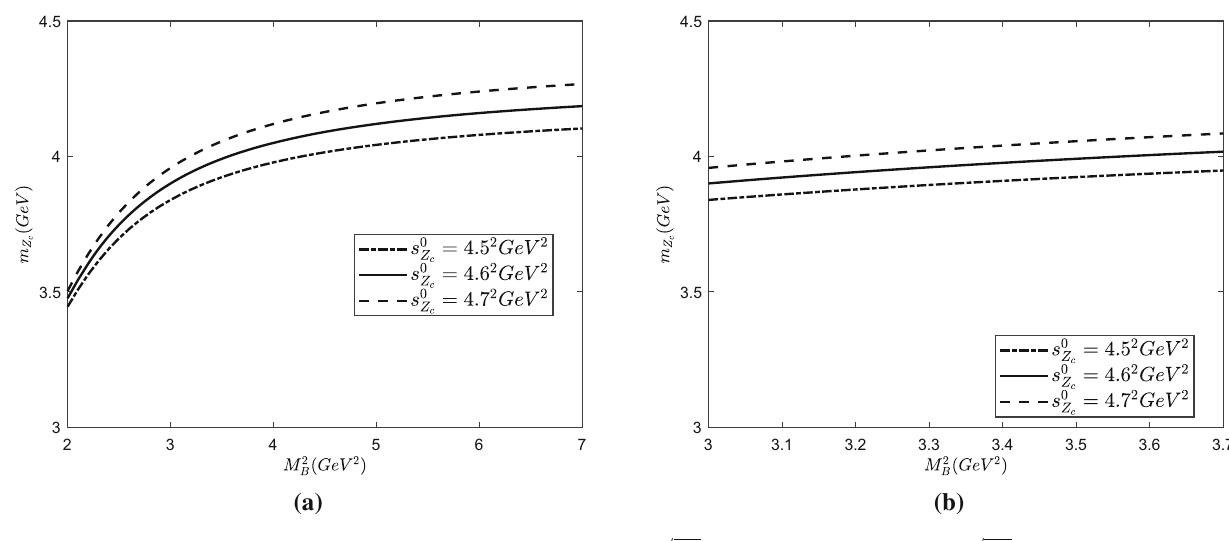
(cid:14) = 4 . 6GeV; b represents RP s 0 with B Z c